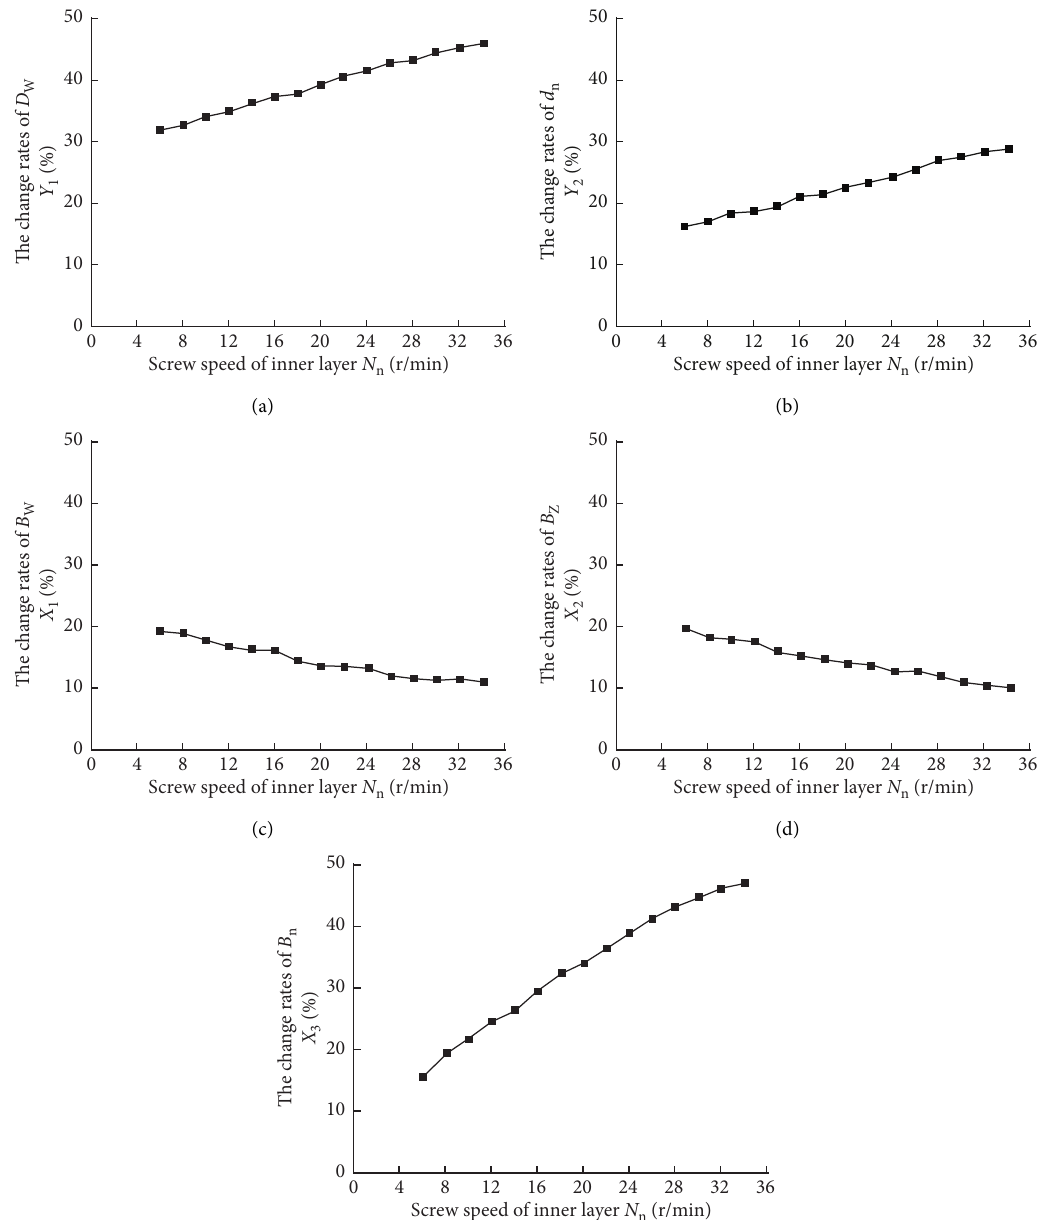
Figure 14: Diameter change rates ((a) outer and (b) inner diameter) and wall thickness change rates ((c) outer layer, (d) middle layer, and (e) inner layer wall thicknesses) of three-layered balloon catheters as a function of screw speed of the inner layer